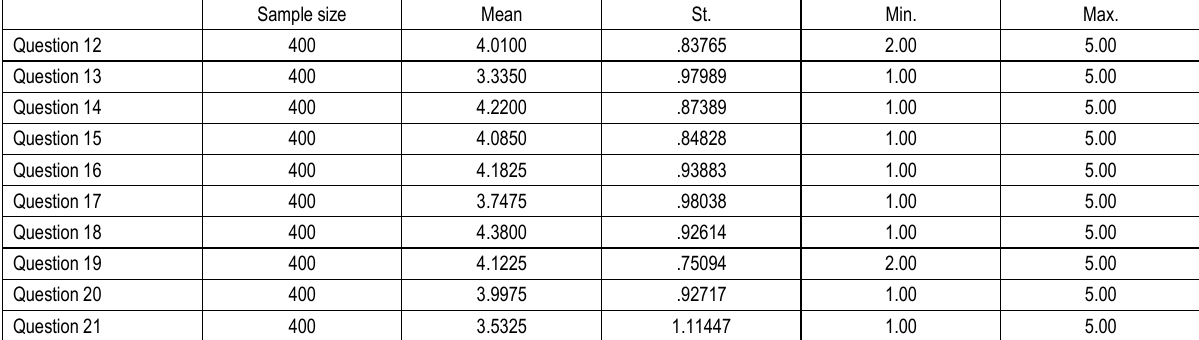
Table 19. Results of descriptive statistics pertaining to factors of loosing bank customers